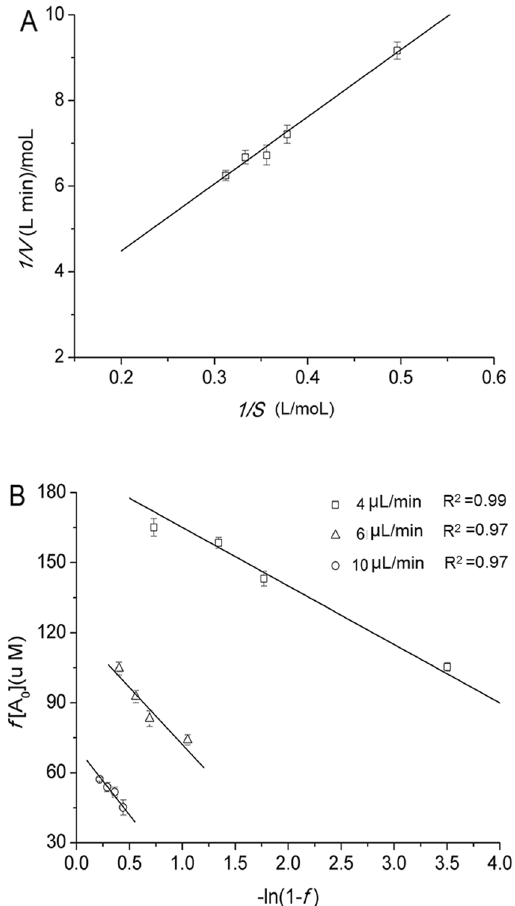
Figure 7. Lineweaver-Burk double reciprocal plots ( A ) and Lilly-Hornby plots ( B ) for graphene immobilized enzyme assay in a batch reactor and a microchannel reactor. Reaction conditions: ( A ) the rutin concentration was 0.1 g/L, the nanoparticle content was 20 mg, the reaction time was 1 h, and the reaction temperature was 50 °C; ( B ) the flow rates in microchannel reactor were 2 μ L/min, 5 μ L/min, and 10 μ L/min; rutin concentrations ranged from 0.18 to 0.32